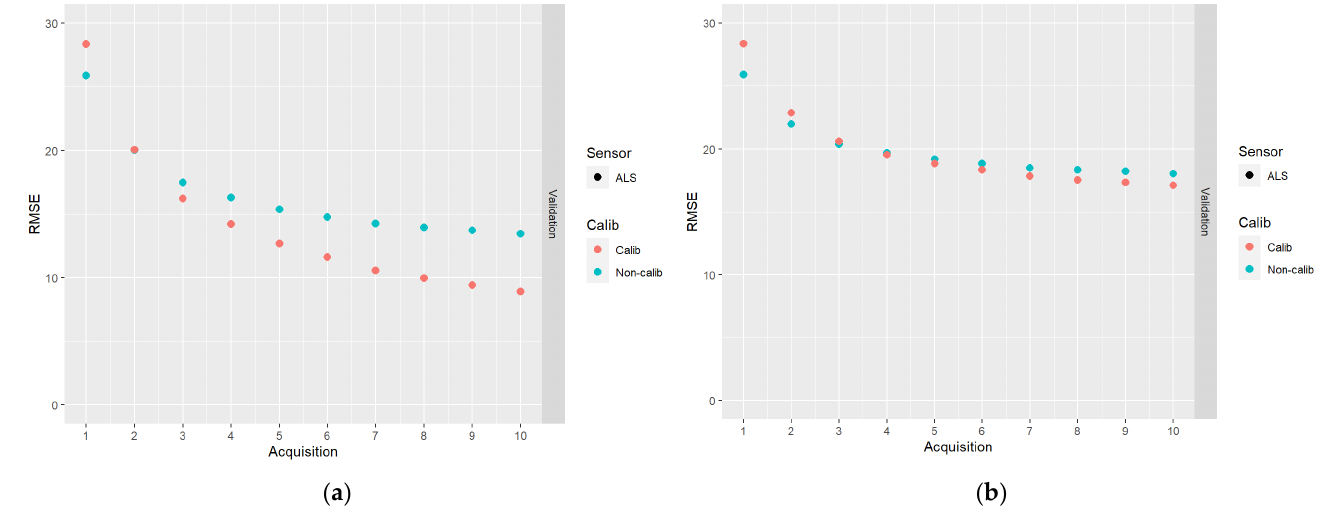
Figure 6. The results of DA schemes applying a sequence of 10 acquisitions of ALS data: ( a ) no correlations between model errors were simulated (case I); ( b ) correlations were simulated accord- ing to Table 2 (case II).